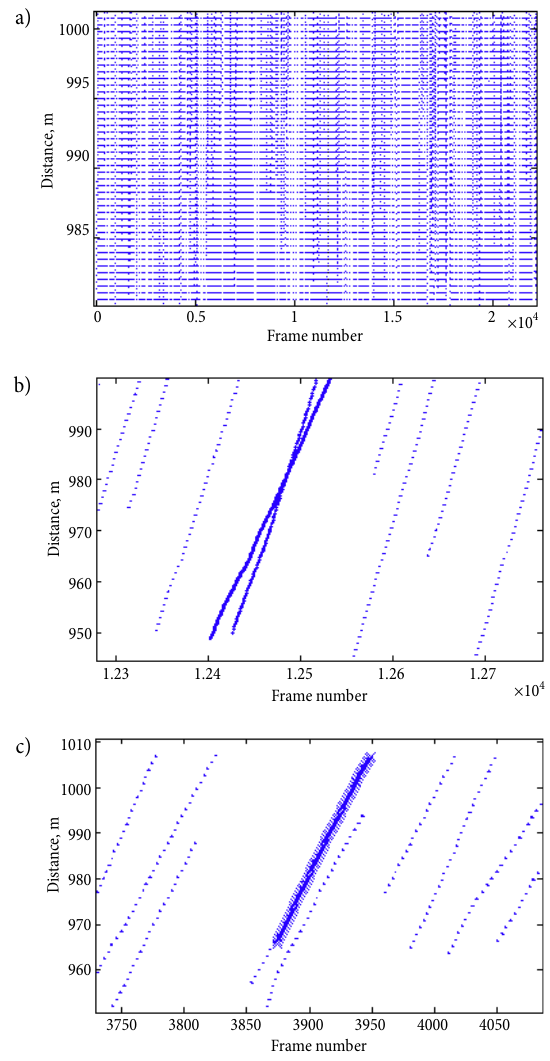
Fig. 2. Snap shots of the vehicular trajectories observed over a single lane of a three-lane wide road, carrying the heterogeneous traffic: a – trajectories of the vehicles moving on a single lane; b – observed overtaking operation on a single lane; c – observed side-by-side movement on a single lane (dotted and the crossed lines representing two